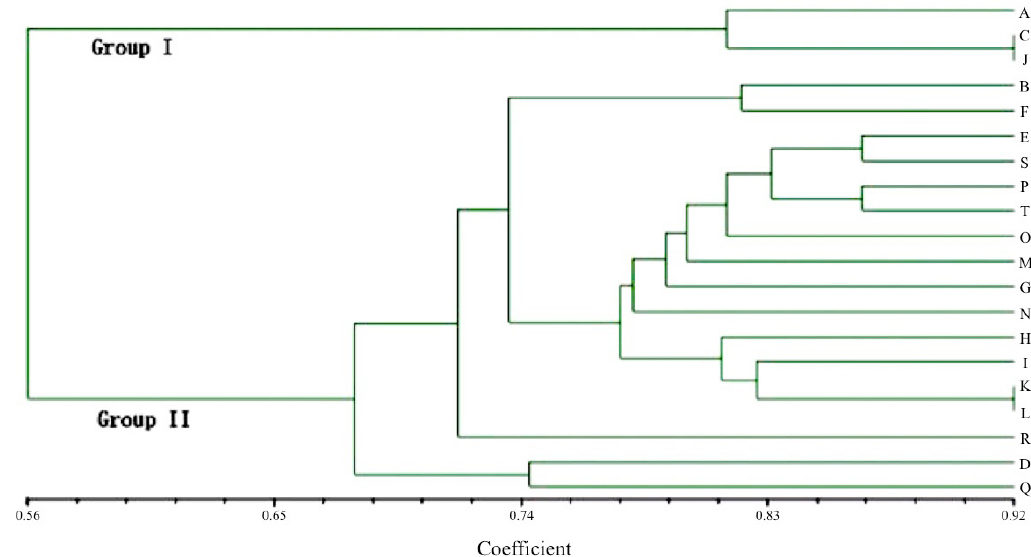
Fig 5 . Dendrogram after unweighted pair-group method with arithmetic mean of O. formosanus based on Nei ’s genetic distance. Population codes are explained in Table 1.